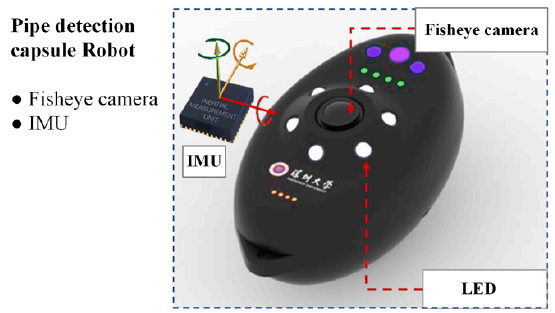
Figure 4. The appearance of the capsule robot.